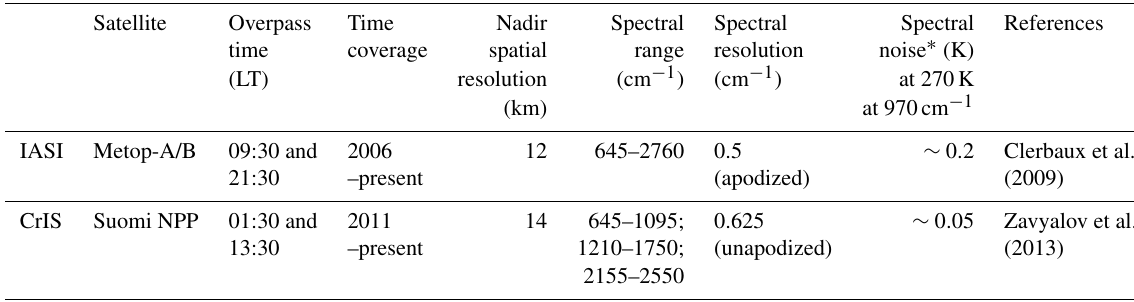
Figure 1. Region of analysis: 400km radius circle around the Paris megacity and 100km around Paris. The latter is representative of the Île-de-France (IdF) region where the Airparif PM observational network is located. Black points are the locations of the Airparif stations measuring hourly PM 2 . 5 concentration at the surface. The black (blue) box delimitates the IdF region in which the IASI NH 3 (ECMWF) data have been considered. The overlay represents NH 3 emissions (in megagrams per year and per cell of 0 . 1 ◦ × 0 . 1 ◦ ) derived from the EMEP inventory for 2015. Map provided by Google Earth V7.3.2.5776, US Dept. of State Geographer, ©Google, 2019, Image Landsat/Copernicus, Data SIO, NOAA, US, Navy, NGA, and GEBCO. Table 1. Instrument specifications for the IASI and CrIS satellite